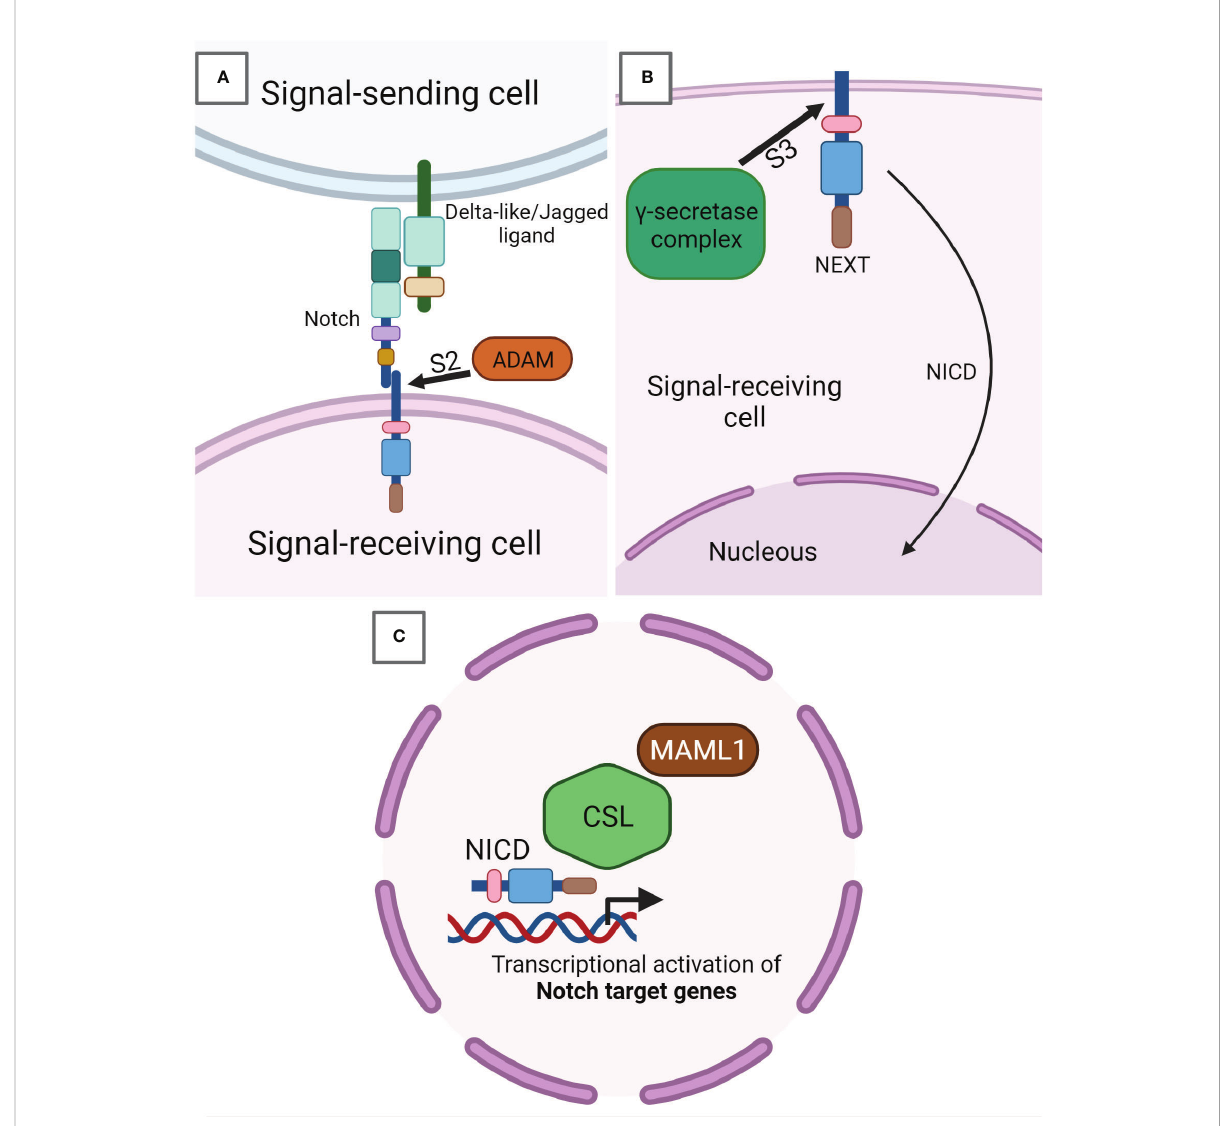
FIGURE 2 Notch signaling pathway. (A) Notch receptor expressed on signal-receiving cell surface binds to Notch-ligand Delta-like or Jagged exposed on the surface of the signal-sending cell. This binding induces a receptor conformational change, which leads to the cleavage in S2 by ADAM metalloproteases. ADAM-mediated cleavage releases the EC portion from the TM-IC subunit of Notch called NEXT (Notch extracellular truncated) and still anchored to the signal-receiving cell membrane. (B) Inside the signal-receiving cell, NEXT undergoes a further cleavage in the IC site S3 by the g -secretase complex, after which the Notch IC domain (NICD) is released from the membrane and able of being translocated into the nucleus. (C) NICD in the nucleus activates the transcription of Notch target genes by inducing the development of a transcriptional complex having CSL as core DNA-binding factor. In this way, the CSL complex shifts its composition from a repressor to a transcription activator. In particular, NICD recruits the coactivator protein mastermind-like 1 (MAML1), which has a pivotal role in the start of Notch target genes